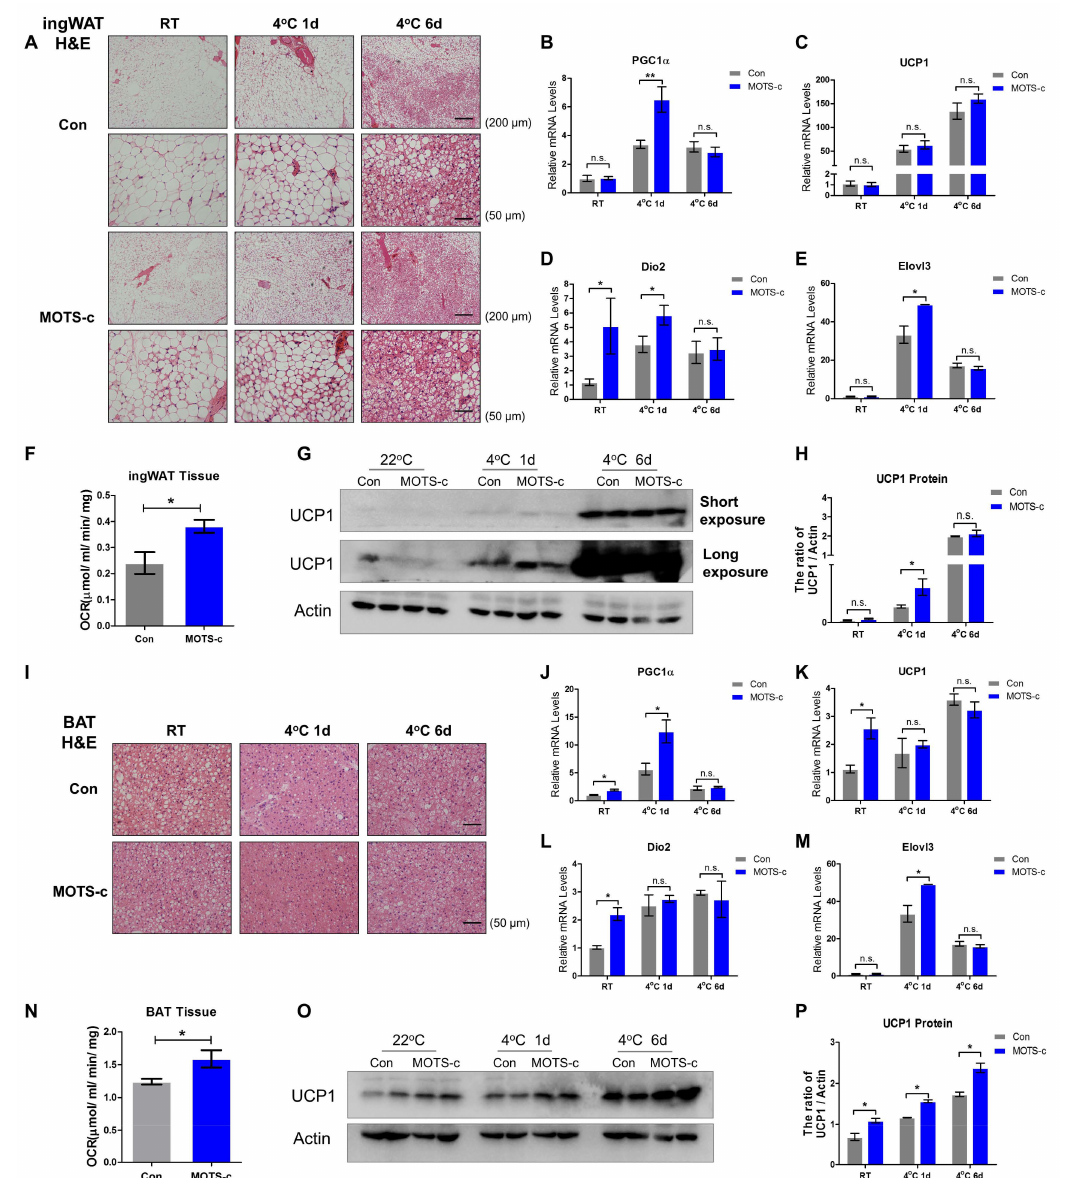
Figure 3. MOTS-c administration promotes white fat browning and Brown Fat Activation during cold exposure. ( A ) H&E staining of ingWAT to show the morphologic change during cold exposure (scale bar = 200 and 50 µ m). ( B–E ) The mRNA levels of genes for thermogenesis (PGC1 α , UCP1, Dio2, and Elovl3) on the first and sixth days of cold exposure ( n = 4, per group). ( F ) Total oxygen consumption per gram in ingWAT from normal saline (Con) and MOTS-c treated mice under basal conditions were measured using a Clark electrode. ( n = 3, per group). ( G , H ) The protein level of UCP1 detected by Western blot and immunoreactive bands were quantified by densitometric analysis using ImageJ ( n = 4, per group). ( I ) H&E staining of BAT to present the morphologic change during cold exposure (scale bar = 50 µ m). ( J–M ) The mRNA levels of genes for thermogenesis (PGC1 α , UCP1, Dio2, and Elovl3) in BAT ( n = 4, per group). ( N ) Total oxygen consumption per gram in BAT from normal saline (Con) and MOTS-c treated mice under basal conditions were measured using a Clark electrode. ( n = 3, per group). ( O , P ) The protein level of UCP1 detected by Western blot and immunoreactive bands were quantified by densitometric analysis using ImageJ ( n = 4, per group). All data are represented as mean ± SEM. Di ff erences between the two groups were determined by a two-tailed Student’s t -test. * p < 0.05, ** p < 0.01, n.s. = not